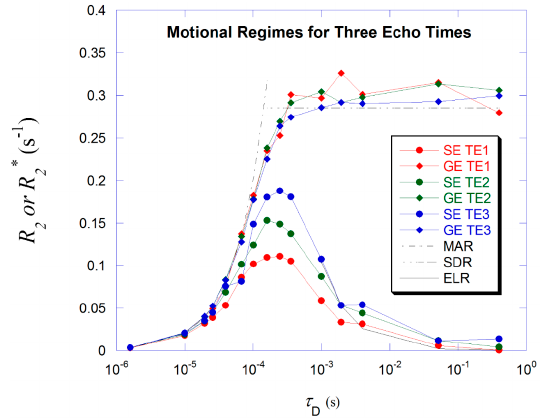
Figure 1. R 2 and R 2 * values are plotted vs. the diffusion correlation coefficient ( τ D ) for three different echo-times (cid:2028) (cid:3004)(cid:3017) = 0.02, 0.05, and 2.0 ms. The agreement of Monte Carlo (MC) values with the asymptotic models in the two limiting regimes is evident for all three echo-times. The echo-limited regime (ELR) dependence on echo-time is also shown (circles) for large particle radii ( (cid:2028) (cid:3005) > 5 × 10 − 4 s). For spin-echo (SE) sequences (large particles) and as the echo-time ((cid:2028) (cid:3004)(cid:3017) ) is reduced the refocusing RF pulses become more effective and partial refocusing occurs and R 2 decreases compared to (cid:1844) (cid:2870)∗ . This is the echo-limited regime (ELR) [32–34] valid for (cid:2028) (cid:3005) > 2(cid:2028) (cid:3004)(cid:3017) , the relaxation time is given by 7.2(cid:1858)(cid:1830)(cid:1876) (cid:2869)/(cid:2871) (1.52+(cid:1858)(cid:1876)) (cid:2873)/(cid:2871) (cid:1844) (cid:2870) = 4(cid:1844) (cid:2870) where (cid:1876) = (cid:2033) (cid:3045) (cid:2028) (cid:3004)(cid:3017) and (cid:2028) (cid:3004)(cid:3017) is half the echo-time in a single Hahn echo or half the 180 RF pulses spacing in a Carr–Purcell sequence. All the above models assume uniform size and magnetization distributions, spherical particle shape, and low volume fractions. The dependence of R 2 on (cid:2028) (cid:3004)(cid:3017) is shown in Figure 1.